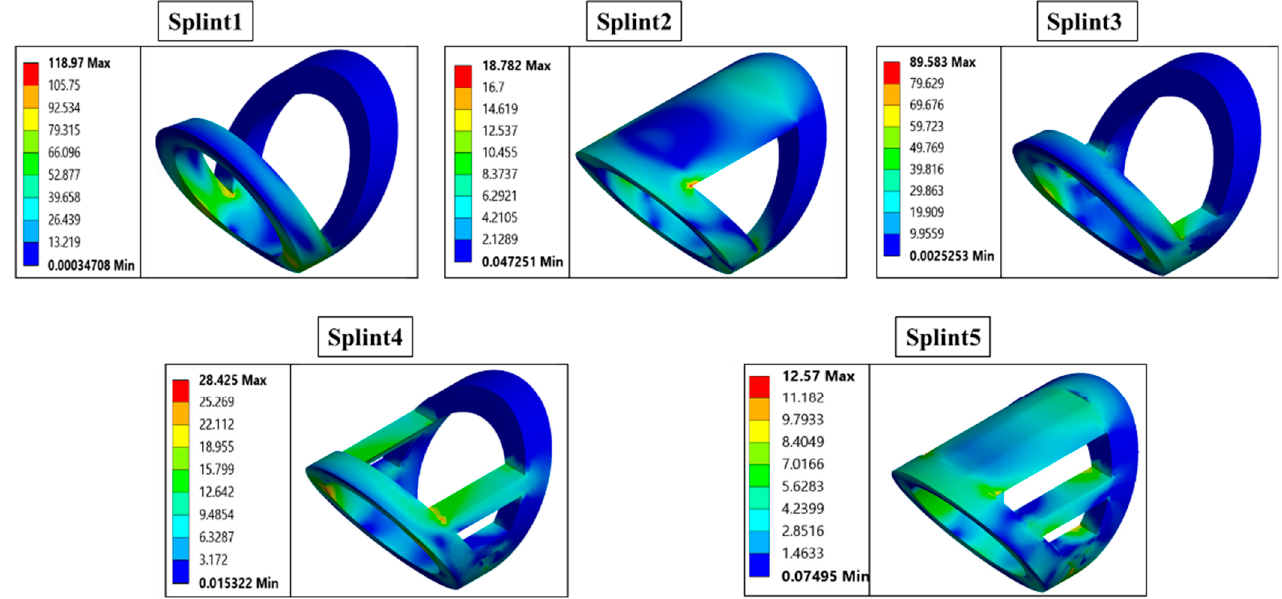
Figure 8. Deformation results of different splint models at 0.64 MPa pressure . Since there were fewer differences seen in the deformation values, the stress analysis was also performed. The total von-Mises stress of designed splints is illustrated in Figure 9. The maximum and minimum stress were induced in splint 1 (118.97 MPa) and splint 5 (12.57 MPa), respectively.